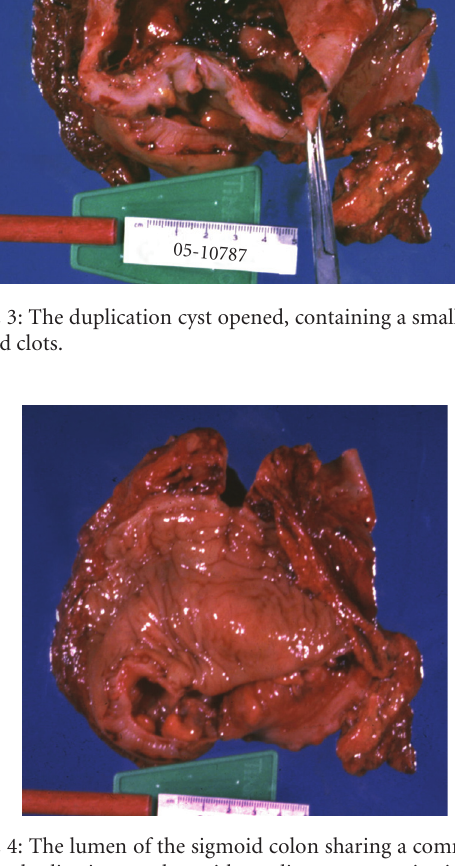
Figure 2: Computed tomography of the abdomen demonstrating the cyst containing an air-fluid level.